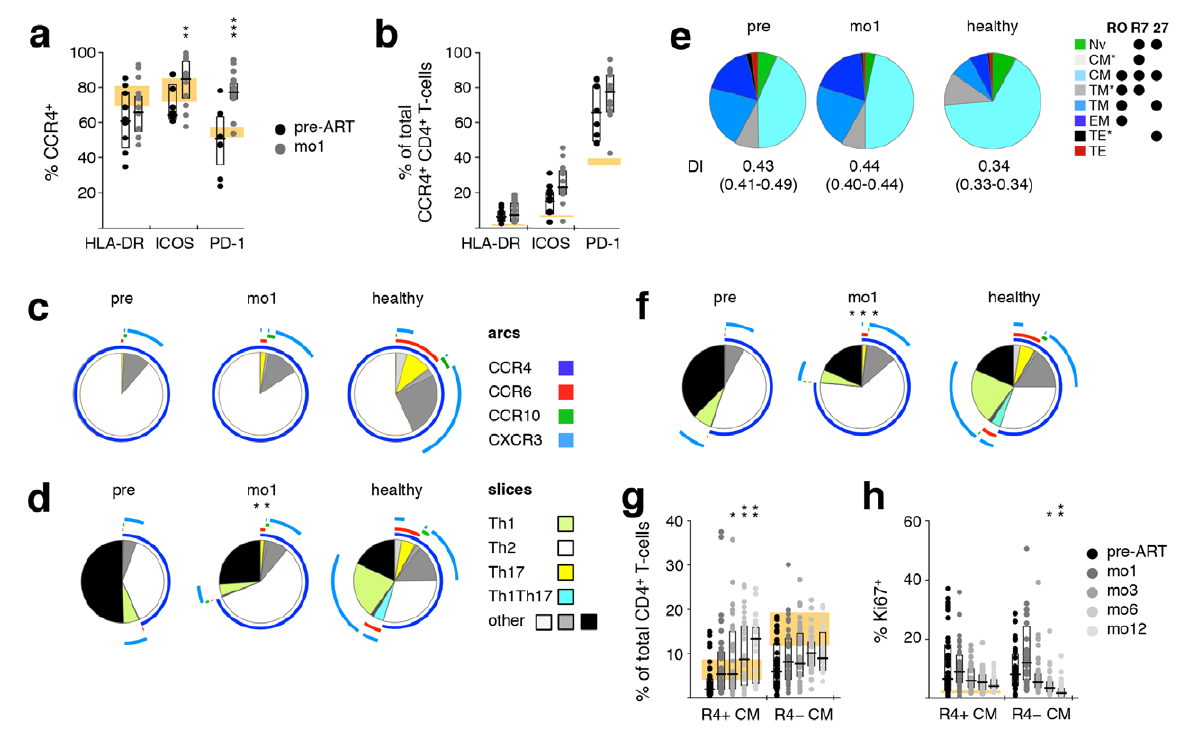
Figure 4. Early appearance of activated CCR4 + T in peripheral blood during ART. PBMC samples taken CM pre-ART and after one month of ART (mo1) were analyzed to investigate co-expression of CCR4, HLA- DR, ICOS, and PD-1 on CD4 + T cells, as well as whether these phenotypes coincide with the T subset. CM (A) Frequency of CCR4 + cells within HLA-DR + , ICOS + , and PD-1 + cells. (B) Frequency of HLA-DR, ICOS, or PD-1 expressing CCR4 + cells. Expression of Th subset-defining chemokine receptors on CCR4 + (C) or non-naïve (D) CD4 + T cells. (E) Differentiation pattern of CCR4 + cells. Differentiation indices (DI; medi- ans and interquartile ranges) are indicated below each pie. (F) Expression of Th subset-defining chemokine receptors on T cells. (G) Proportion of CCR4 + T and CCR4 − T over time. (H) Expression of the CM CM CM proliferation marker Ki67 in CCR4 + T and CCR4 − T over time. Bar graphs show interquartile ranges, CM CM median bars, as well as individual data points. The interquartile range of given phenotypes (orange areas in bar charts) or average distribution patterns (pie charts) in healthy donors are shown. Mo1 measurements were compared to corresponding pre-ART values: * P < 0.01, ** P < 0.001, *** P <